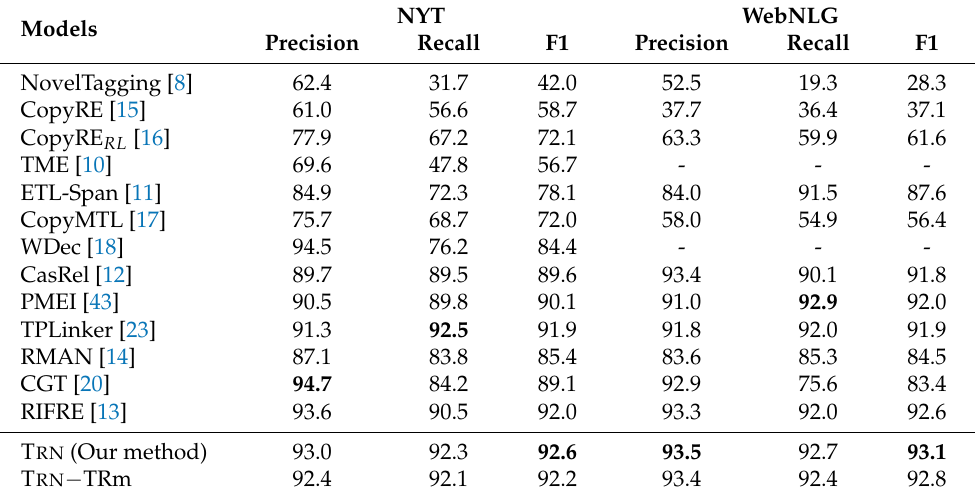
Table 2. The performance of our proposed T RN and previous models on the NYT and WebNLG test sets. T RN − TRm indicates the model does not use the triples’ reasoning module presented in Section 3.3. The best scores are in bold font.